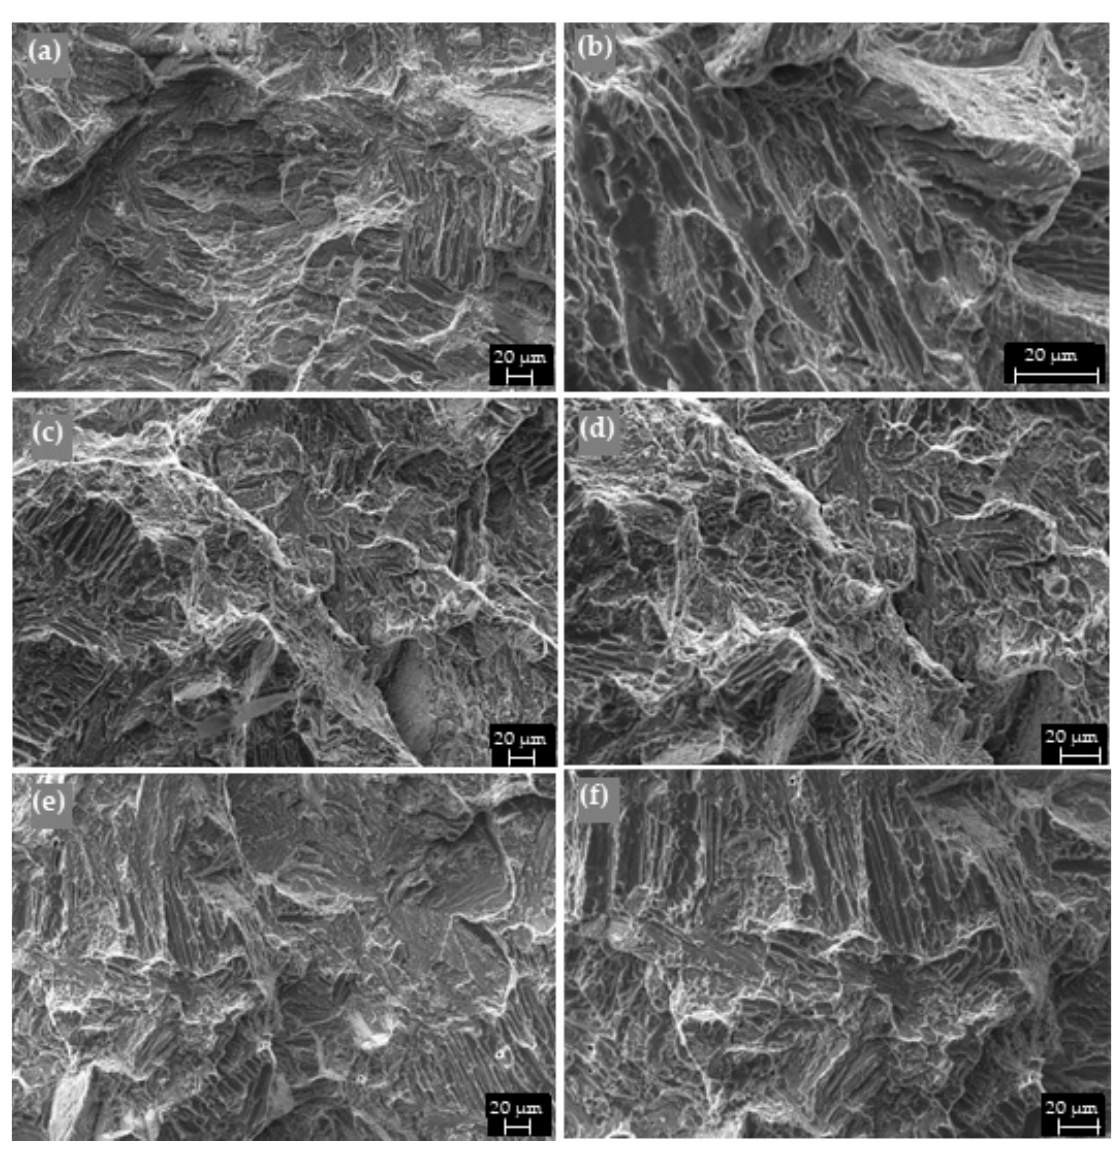
Figure 8. Fractographs of Charpy impacted specimens of Ti-6Al-4V alloy ( a , b ) as-extruded ( c , d ) HT-A heat treated ( e , f ) HT-B heat treated.